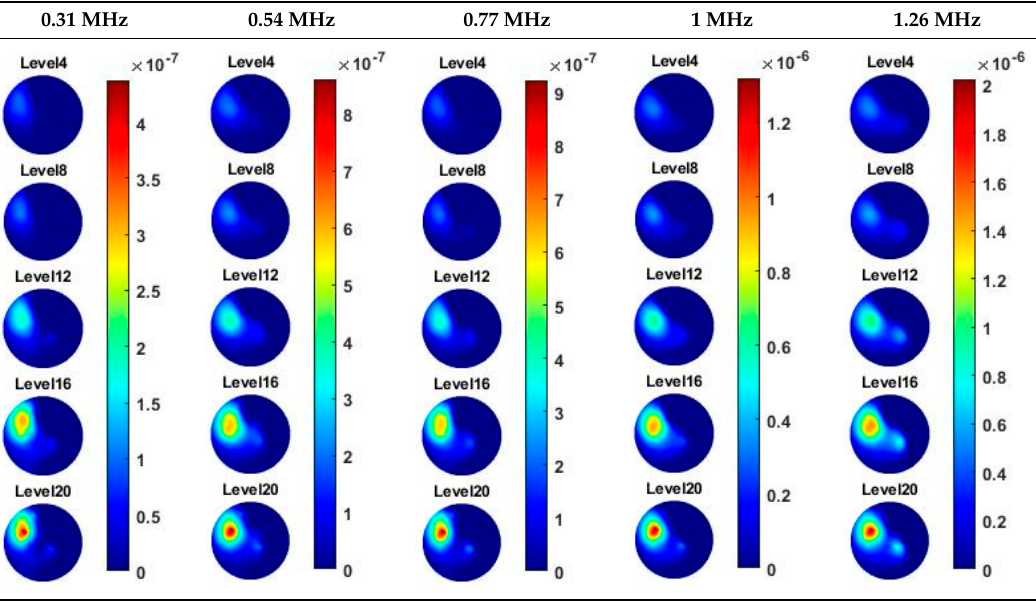
Table 4. Sliced image of horizontal layer for double corn kernels with multi-frequency.